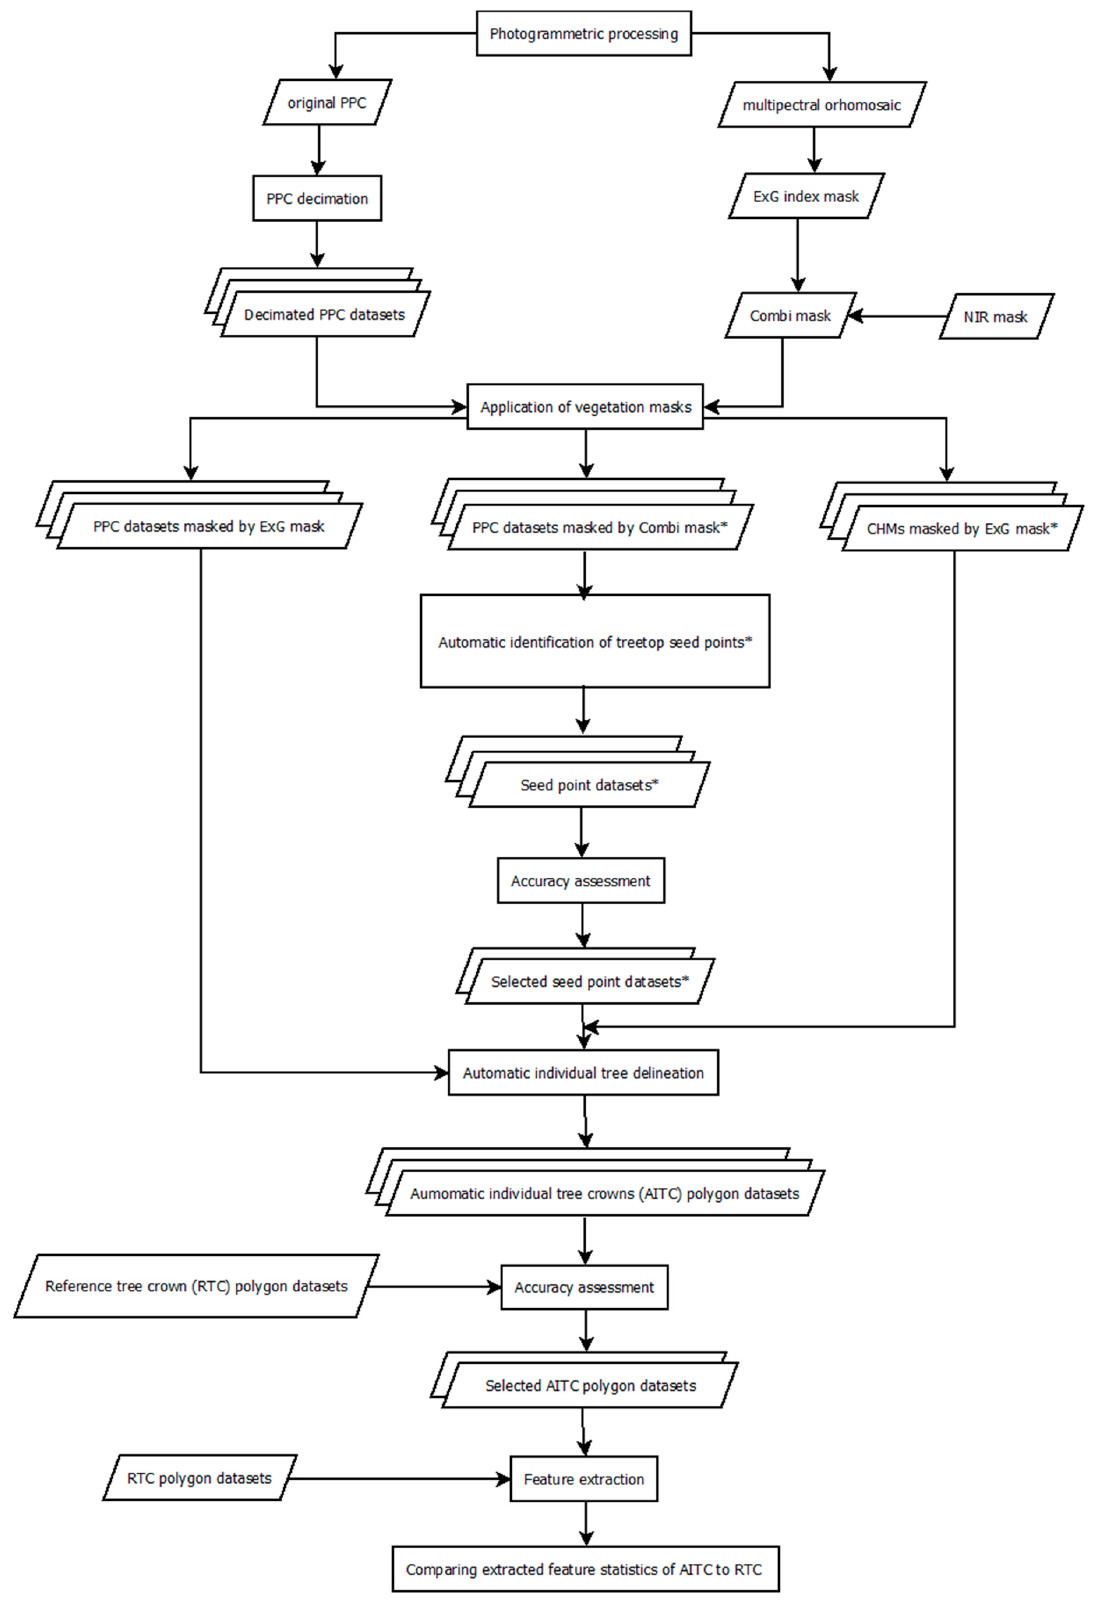
Figure 2. The processing workflow suggested in this study. Steps marked with * are optional regarding to used ITCD method. These steps are necessary for Dalponte2016 and Marker controlled watershed segmentation methods in this study.